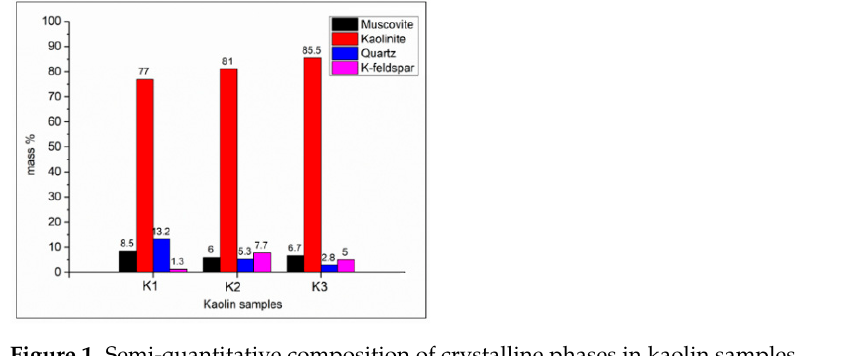
Figure 1. Semi-quantitative composition of crystalline phases in kaolin samples.